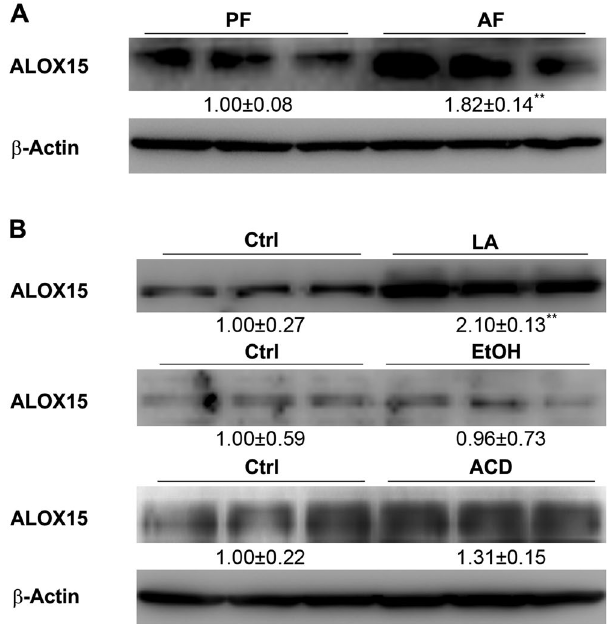
Figure 3. Linoleic acid induced ALOX15 expression. WT male mice were fed with control (PF) or alcohol (AF) liquid diet for 8 weeks. ( A ) Immunoblot of liver ALOX15. ( B ) Immunoblot of ALOX15 in Hepa-1c1c7 cells treated with linoleic acid, ethanol, or acetaldehyde. Protein levels were quantitated by NIH image J. All values are denoted as means ± SD (n = 3). ** P <